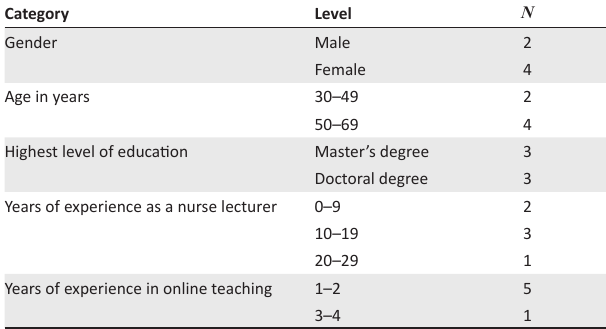
TABLE 1: Participants’ demographic profile ( N = 6).